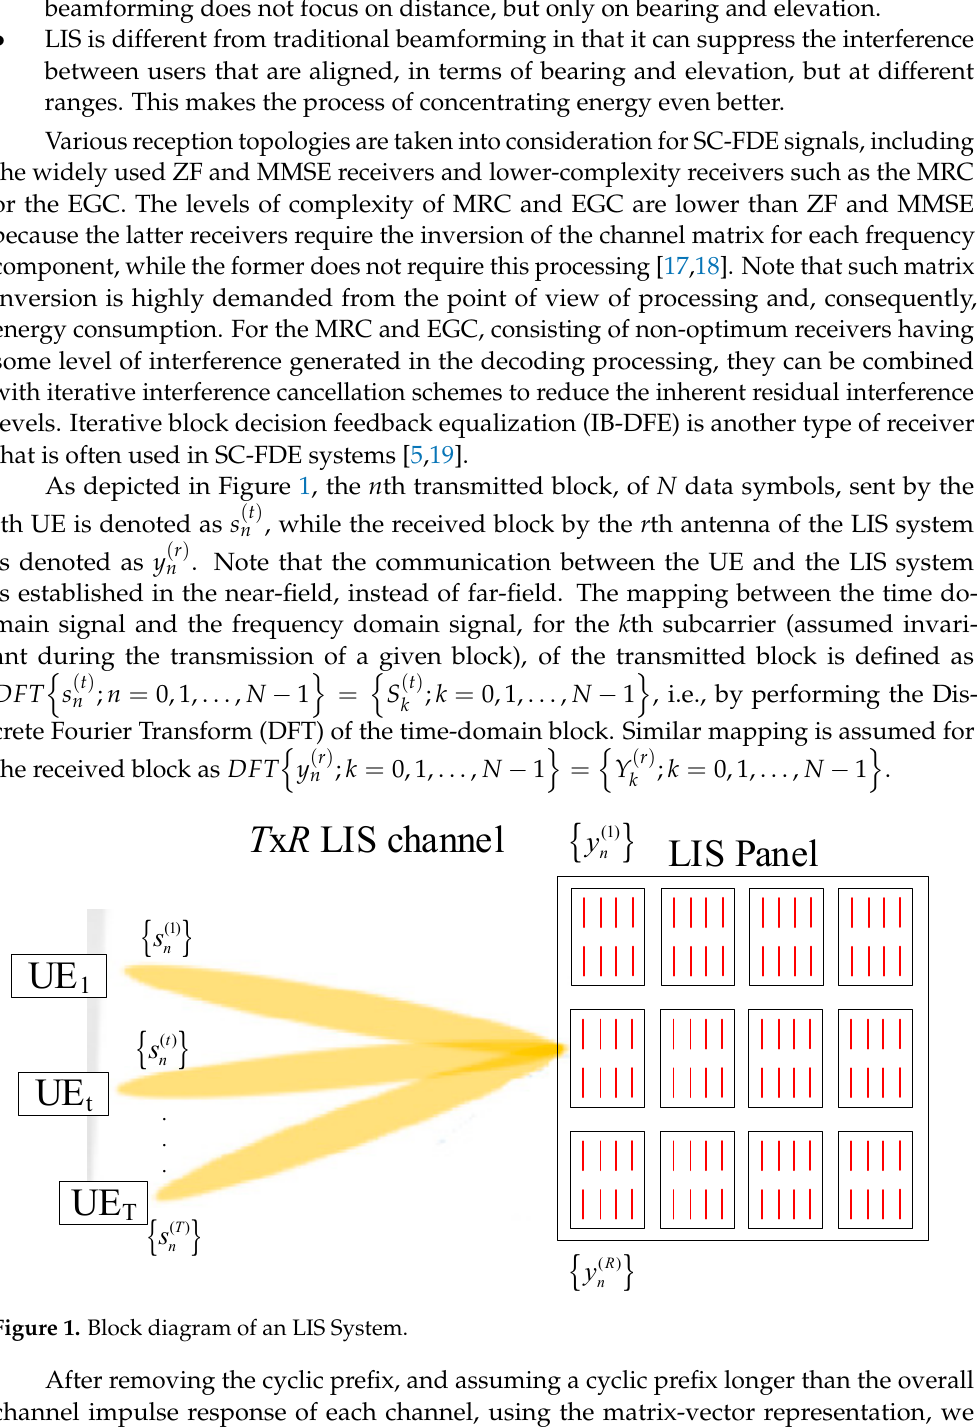
Figure 1. Block diagram of an LIS